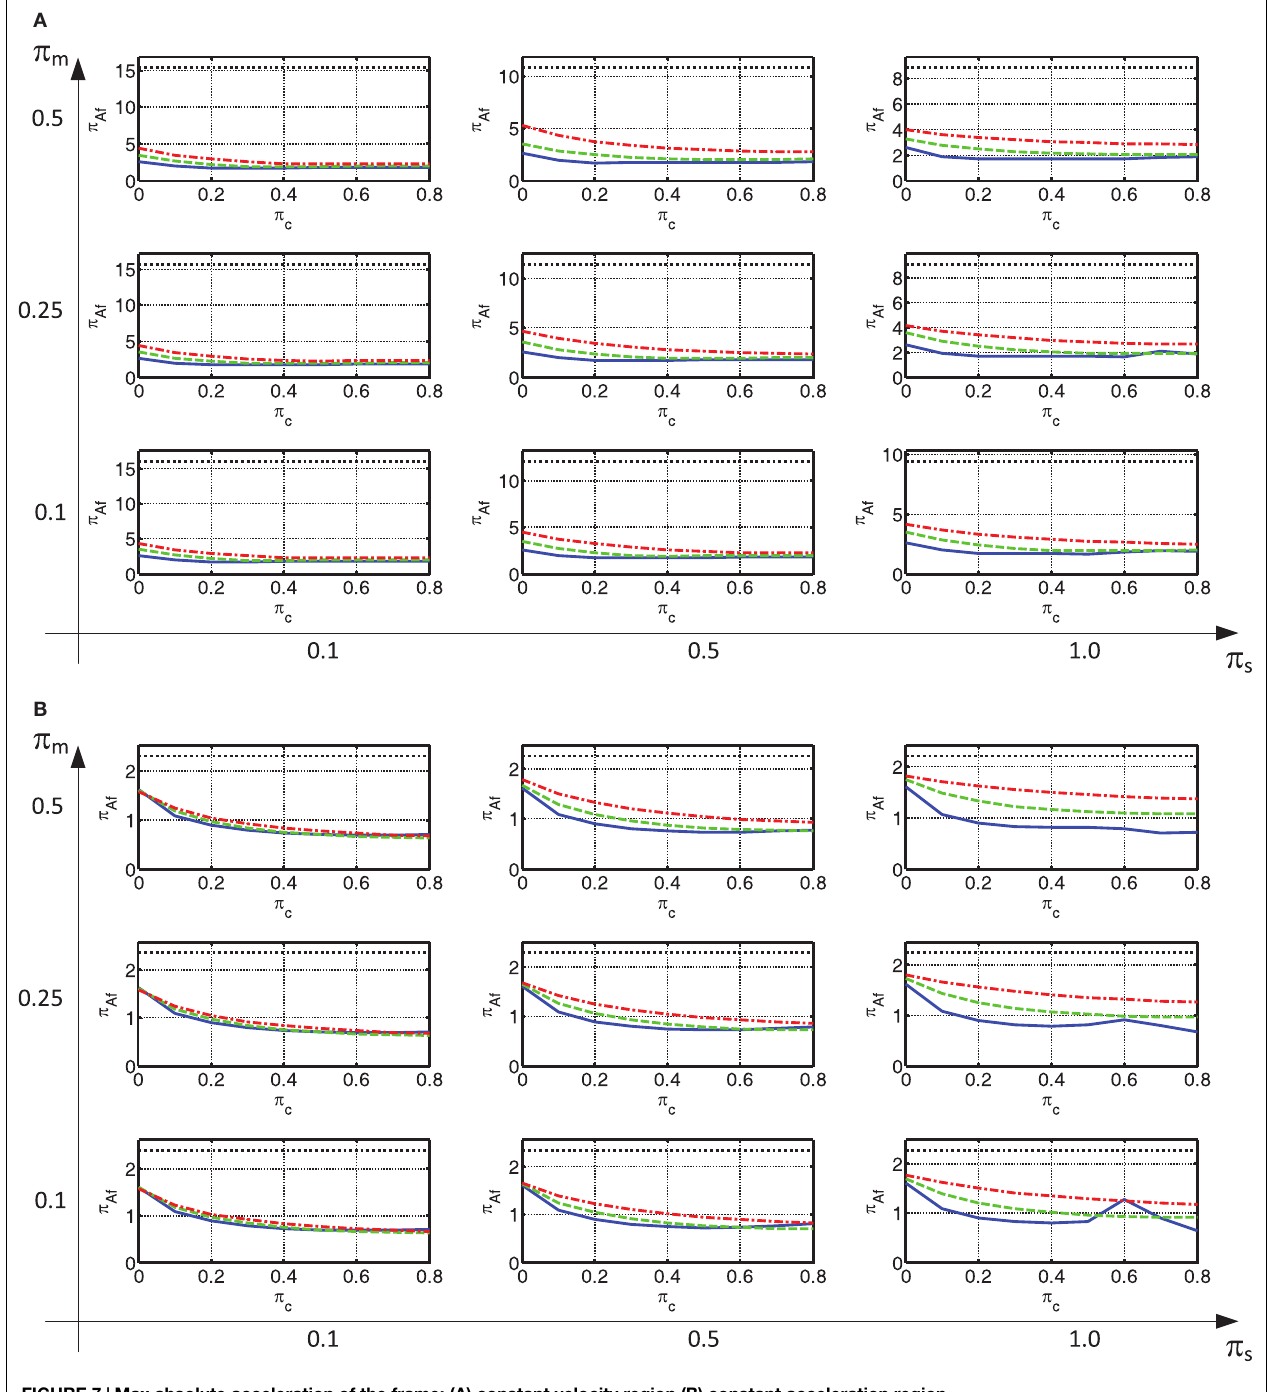
FIGURE 7 | Max absolute acceleration of the frame: (A) constant velocity region (B) constant acceleration region